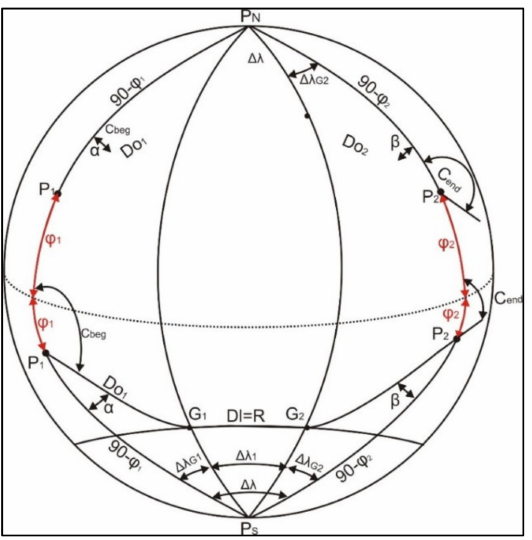
Figure 5. Composite navigation elements in the northern and southern